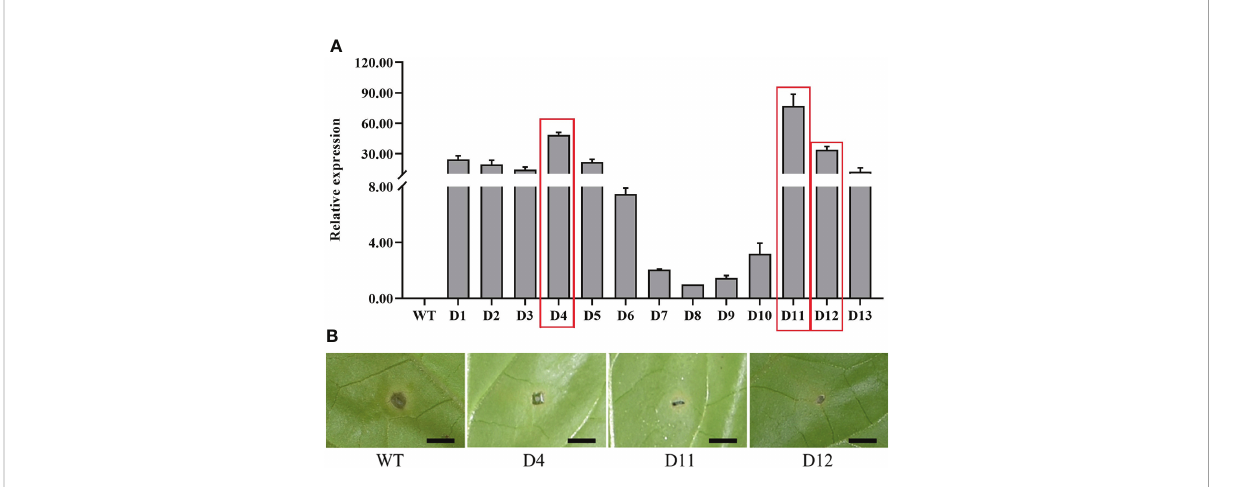
FIGURE 5 (A) The relative expression level of CoDFR in transgenic tobacco plants, red boxes indicate the three transgenic tobacco lines with high relative expression. (B) Phenotypes of transgenic tobacco after Co. fructicola infection, scale bar is 0.5